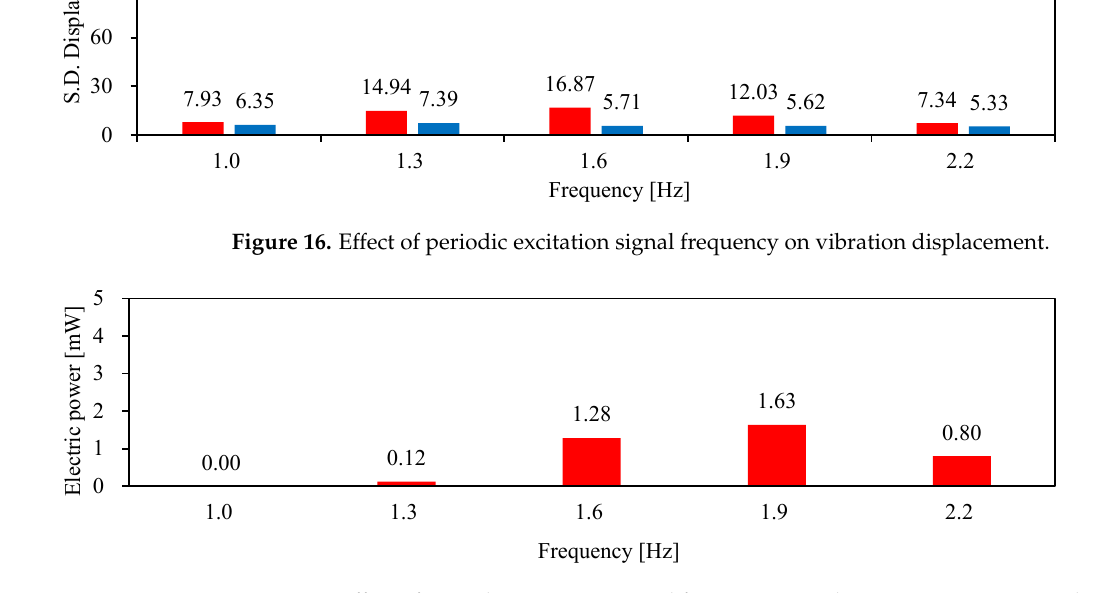
tively. In Figure 16, the red and blue bar graphs show the vibration displacements of the mass block and support point, respectively. As the excitation frequency increased, the vi-